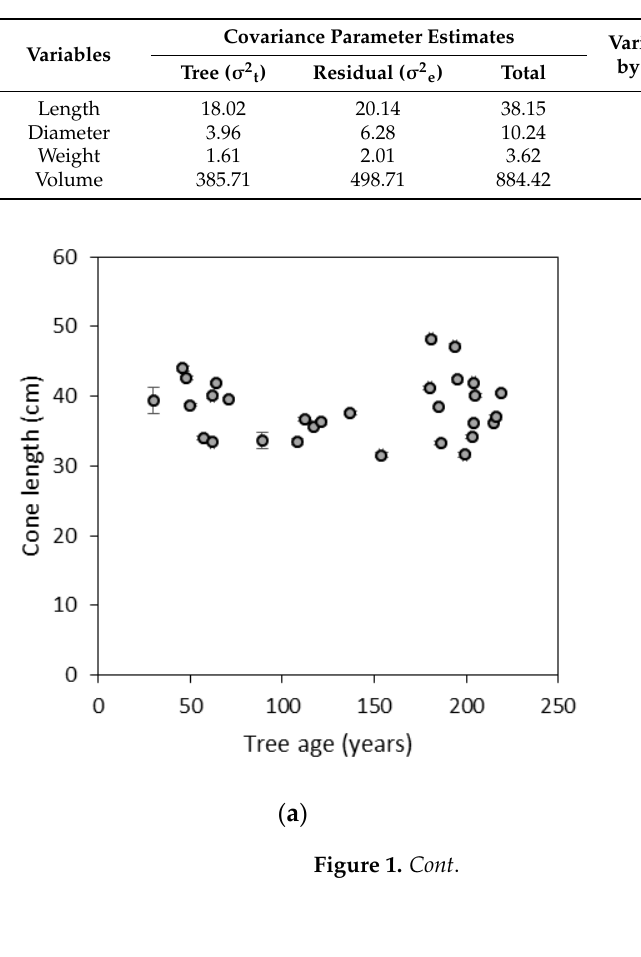
Table 2. Between-Tree Variability and Effect of Tree Age on Morphological Parameters of Cones.